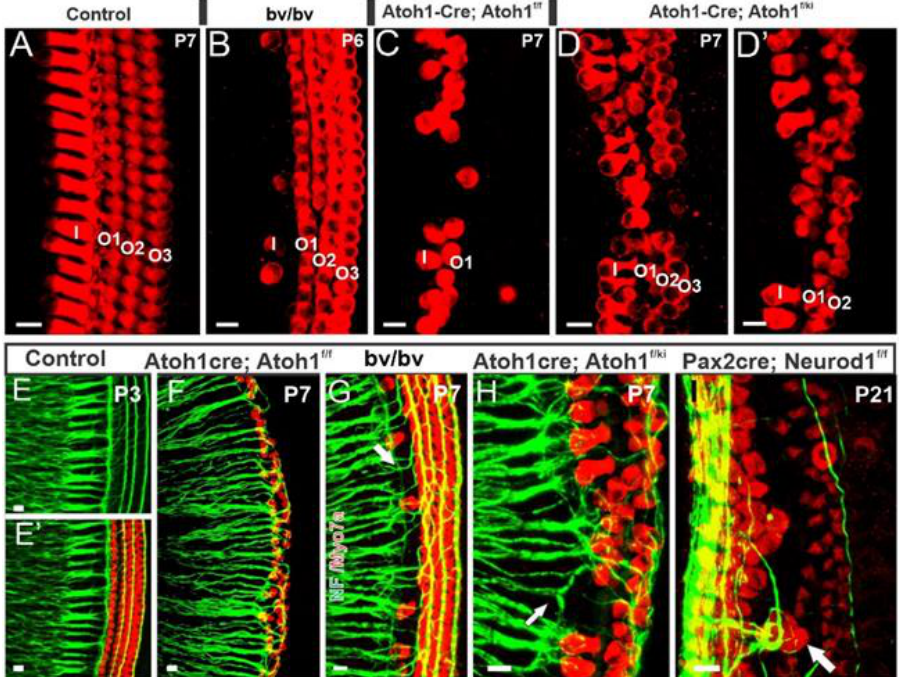
Figure 5. Innervation of the cochlea depends on the presence of hair cells. Detailed images are comparing hair cells and inner ear afferents in control mice ( A ), Bronx waltzer (bv/bv) ( B ), and “self-terminating” Atoh-cre; Atoh1 f/f ( C ), and Atoh-cre;Atoh1 KI/f ( D , D’ ) mice. Hair cells are reduced, and inner ear innervation is disorganized in these mice. Immunolabeling for neuronal markers demonstrates the normal inner ear afferents in control mice ( E , E’ ). This is compared with Atoh- cre;Atoh1 f/f ‘self-termination mice ( F ), Bronx waltzer ( bv/bv ) ( G ), Atoh-cre ; Atoh1 ki/f ( H ) and Pax2-cre; Neurod1 ( I ). Bar 10 µ m. Modified after